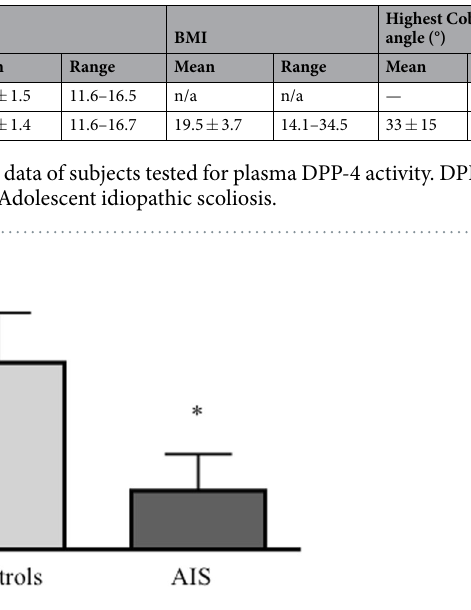
Figure 1. Plasma DPP-4 activity. DPP-4 activity was measured using the DPPIV/CD26 Enzo Life Science’s assay kit in plasma of 113 AIS girls and 62 age-matched controls. * P < 0.05 using two-tailed Student’s t-test. Data are presented as mean ± standard